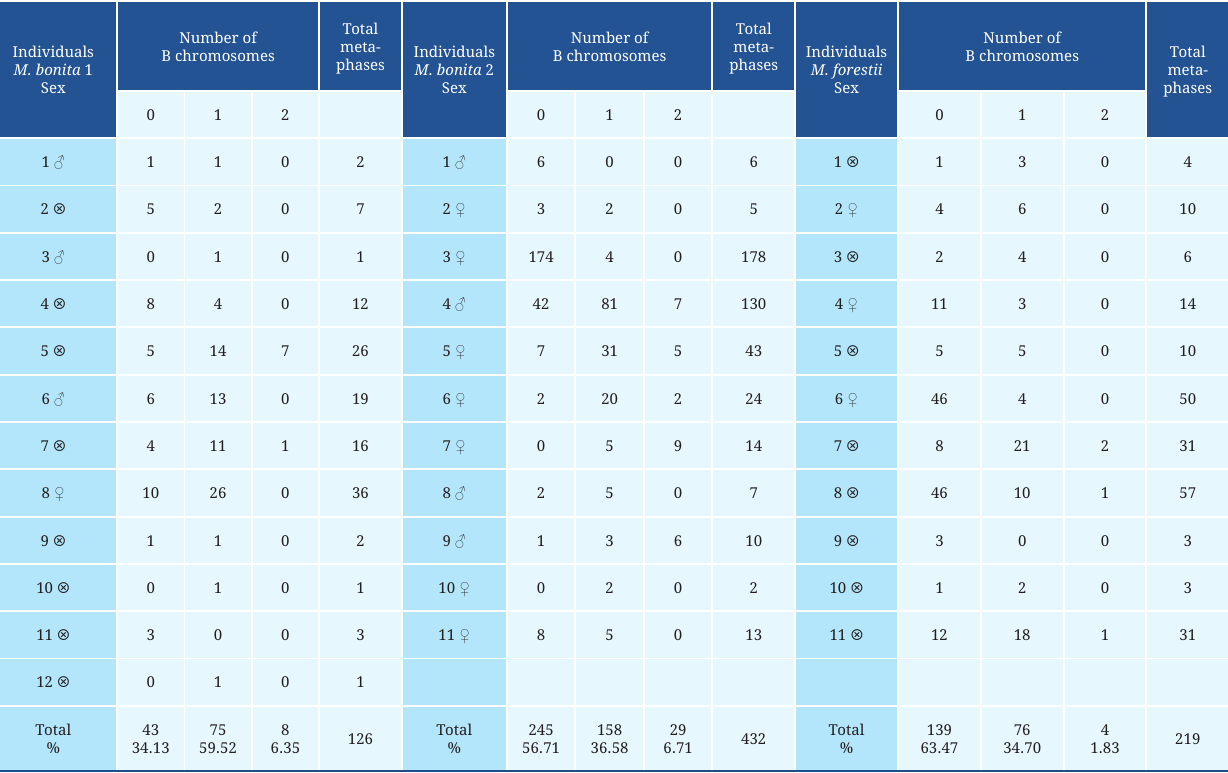
TABLE 2 | Frequency of B chromosomes in metaphases of Moenkhausia bonita 1 from Índios River (Paraná, Brazil), M. bonita 2 and M. forestii from Paraná River (Paraná, Brazil). Simbols: ♀ female; ♂ male; V unidentified sex.